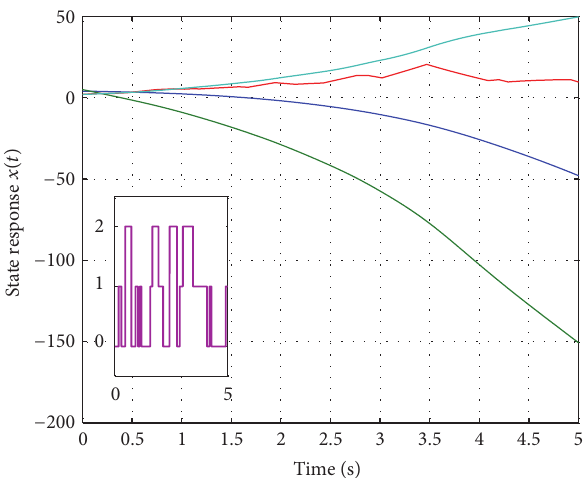
Figure 6: State response of the open-loop VTOL helicopter system.